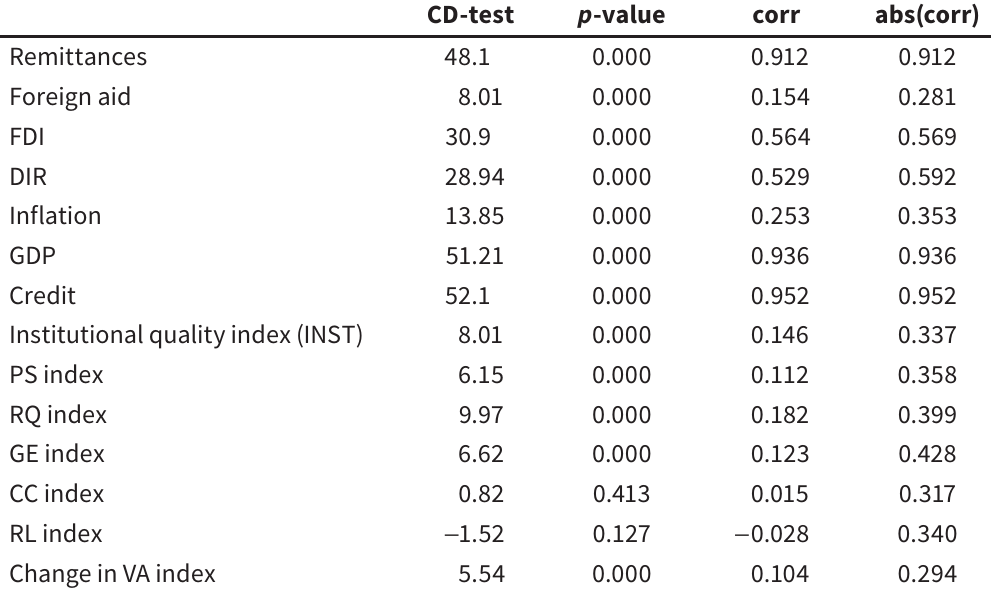
Pesaran CD test